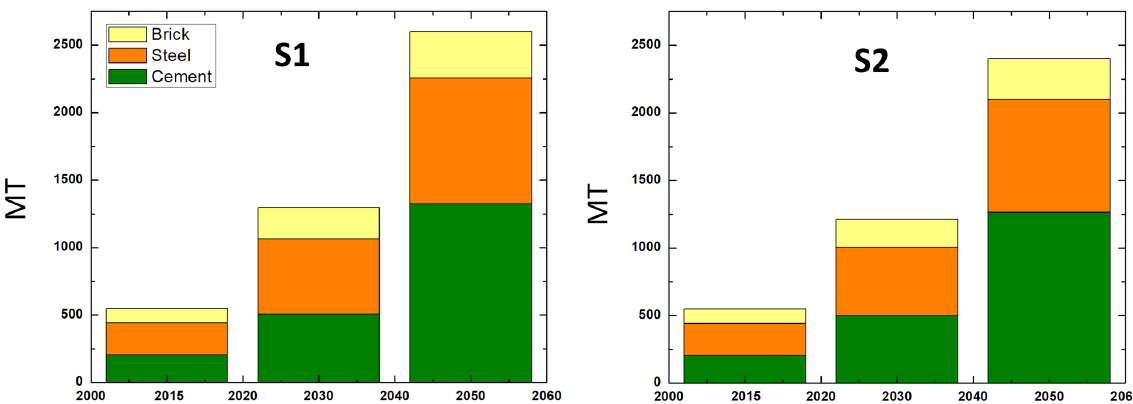
Figure 2. Total emission estimation under Reference scenario (S1) and moderate energy efficient scenario (S2) over study period of 2015 to 2050 in MT CO 2 with sectoral